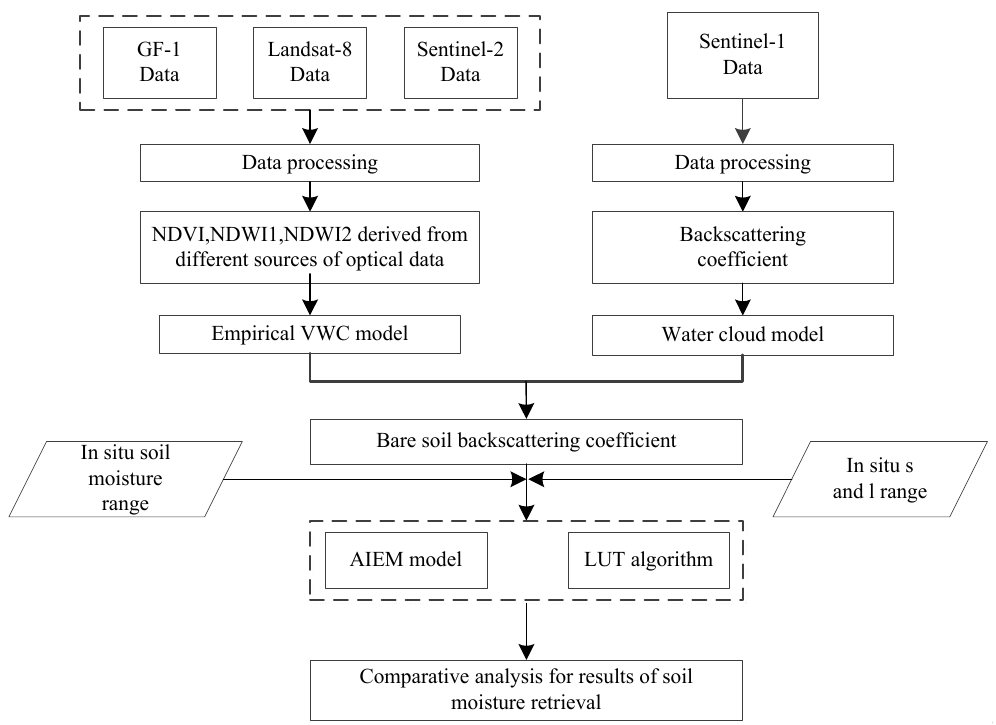
Figure 2. Flowchart of the soil moisture retrieval based on GF-1, Landsat-8, and Sentinel-1/2.